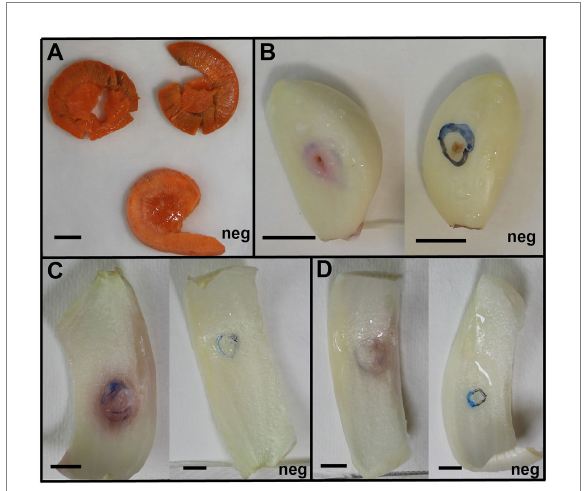
FIGURE 3 Erwinia persicina SR13-16 cause soft rot on carrots, garlic, white and yellow onions. Examples of soft rot caused by E. persicina SR13-16 isolates. All vegetables were incubated at 30 ° C and pictures were taken after 48 h for the yellow onion (C) and white onion (D) , 72 h for the carrots (A) , and 96 h for the garlic (B) . Negative controls, inoculated with sterile buffer solution, are marked with “Neg” in each panel. Scale bars equal 1 cm. A pink pigmentation accompanies soft rot symptoms on garlic and both onion varieties (C,D)